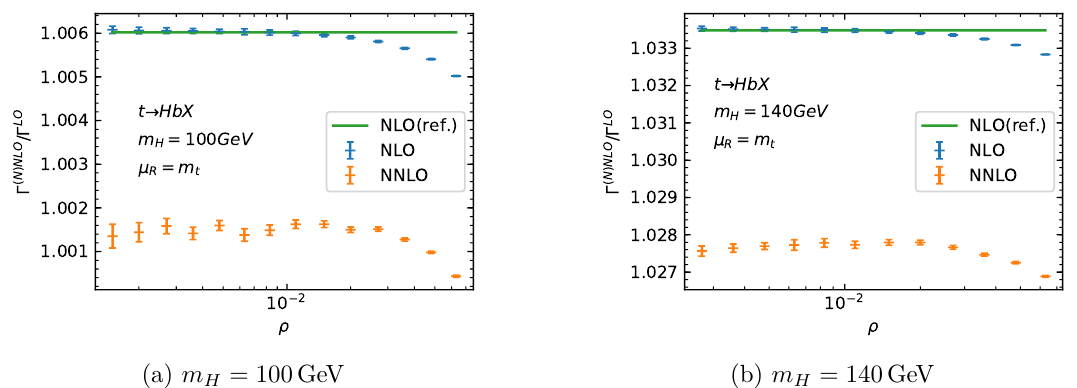
Figure 4. Dependence of the partial decay width on the phase space slicing parameter cut-off ρ cut for the top quark decaying into a 100 GeV (left) or a 140 GeV (right) charged Higgs boson and jets. The ρ parameter is defined in eq. (2.3). The green horizontal lines represent the analytical predictions of the NLO partial decay width. The blue (orange) scatter points with error bars represent our NLO (NNLO) predictions. The renormalization scale is set to the pole mass of the top quark. All predictions are normalized to the LO partial width Γ LO with m H = 100 GeV (left) t → Hb or 140 GeV